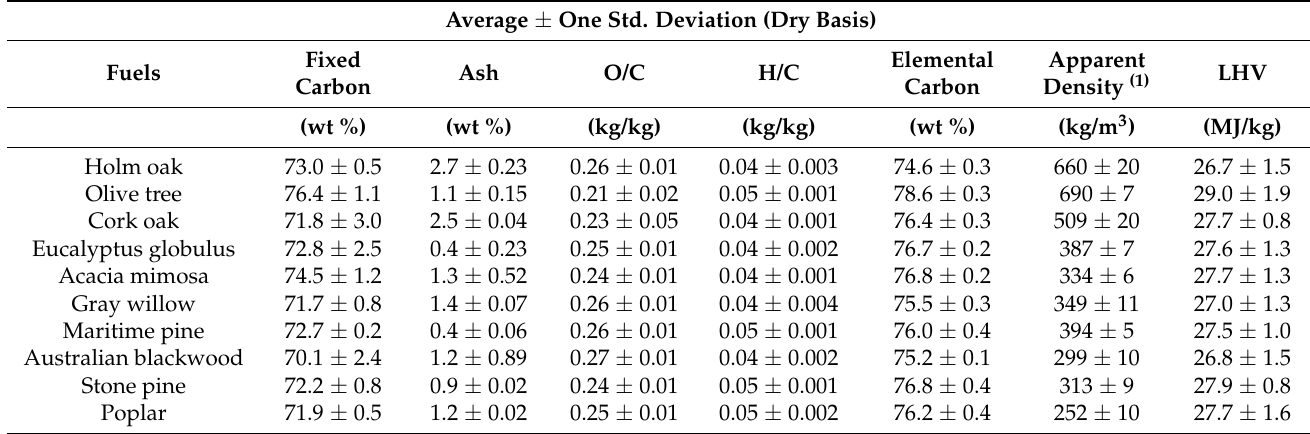
Table 2. Properties of the charcoals obtained at 1 ◦ C/min and final temperature of 400 ◦ C.